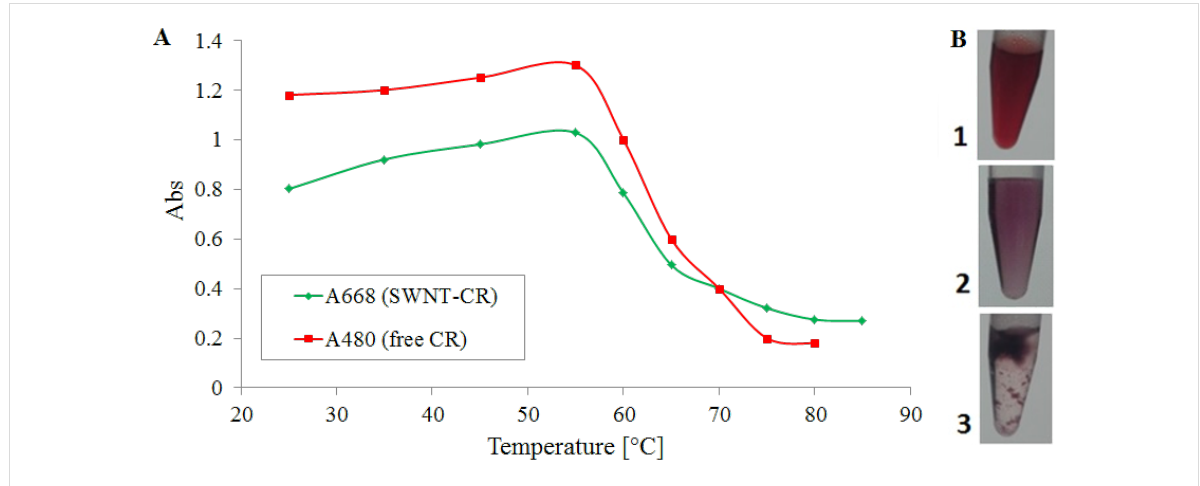
Figure 7: Precipitation of the SWNT–CR complex upon incubation at increasing temperature; (A) absorption spectra of the supernatant – decrease of absorption at 480 nm means that CR is not released from the complex; (B) macroscopic images of the samples: 1. CR solution; 2. SWNT–CR com- plex at room temperature; 3. SWNT–CR complex after heating above 60